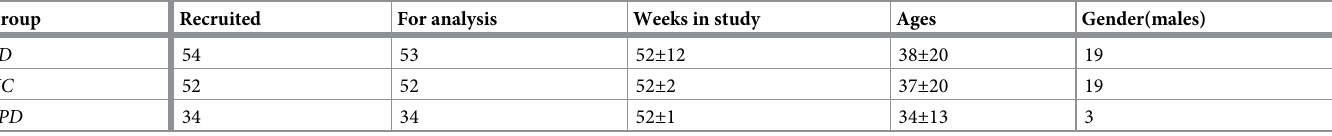
Table 1. Demographic characteristics of the three groups (the appropriate distributions are summarised in the form of the median + / − in the interquartile range).